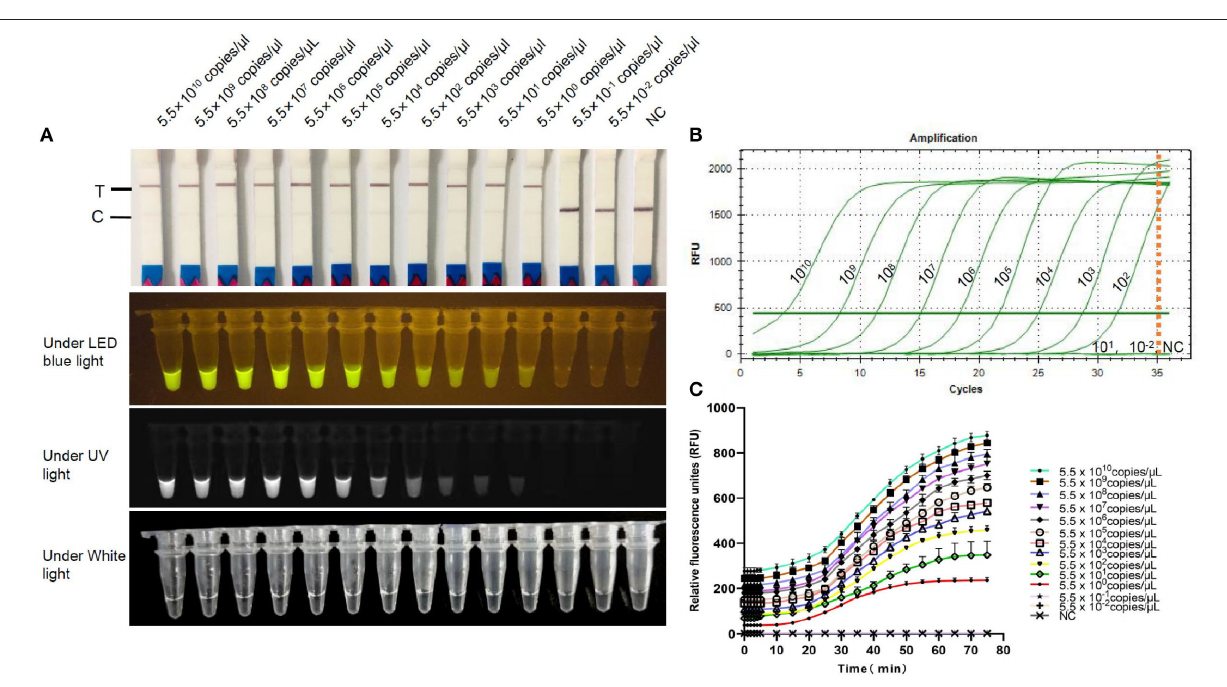
Frontiers in Veterinary Science |